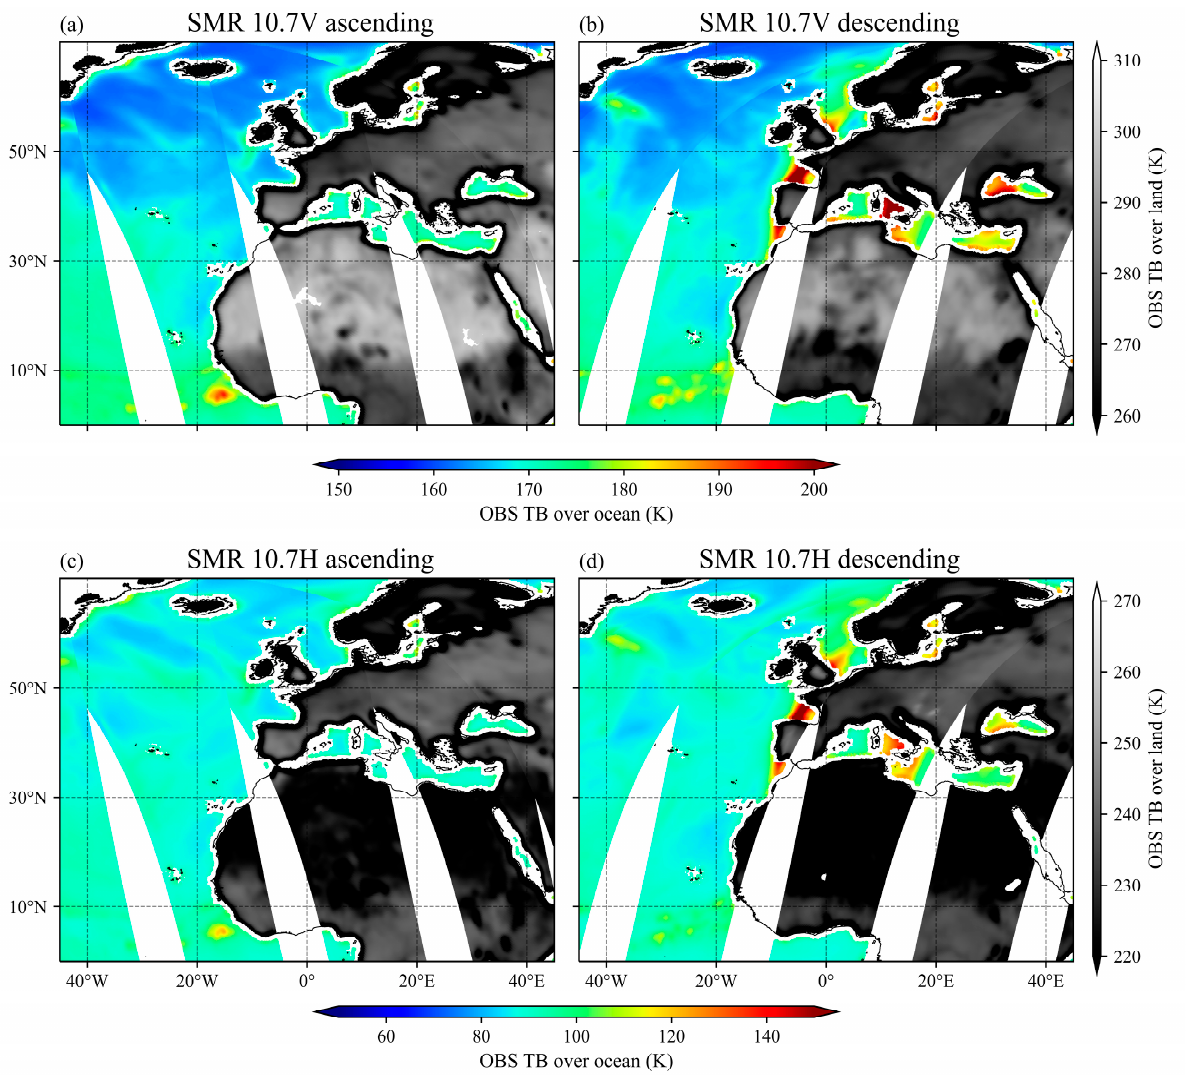
Figure 10. The spatial distribution of observed TBs for the SMR 10.7 GHz channels from 1200 UTC 10 July 2021 to 1200 UTC 11 July 2021 for ( a ) the 10.7 V channel, ascending data, ( b ) the 10.7 V channel, descending data, ( c ) the 10.7 H channel, ascending data, and ( d ) the 10.7 H channel, descending data. Two different colored bars are used for the observed TBs over ocean and over land, respectively.